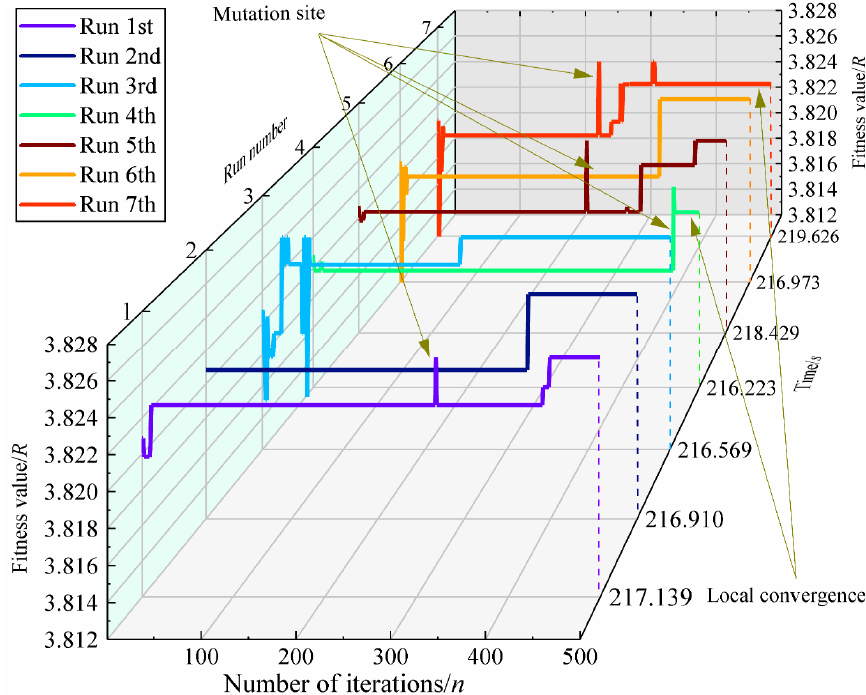
Figure 7. Ratio of number of iterations of the IGA ( n ) to strength ratio ( R ).